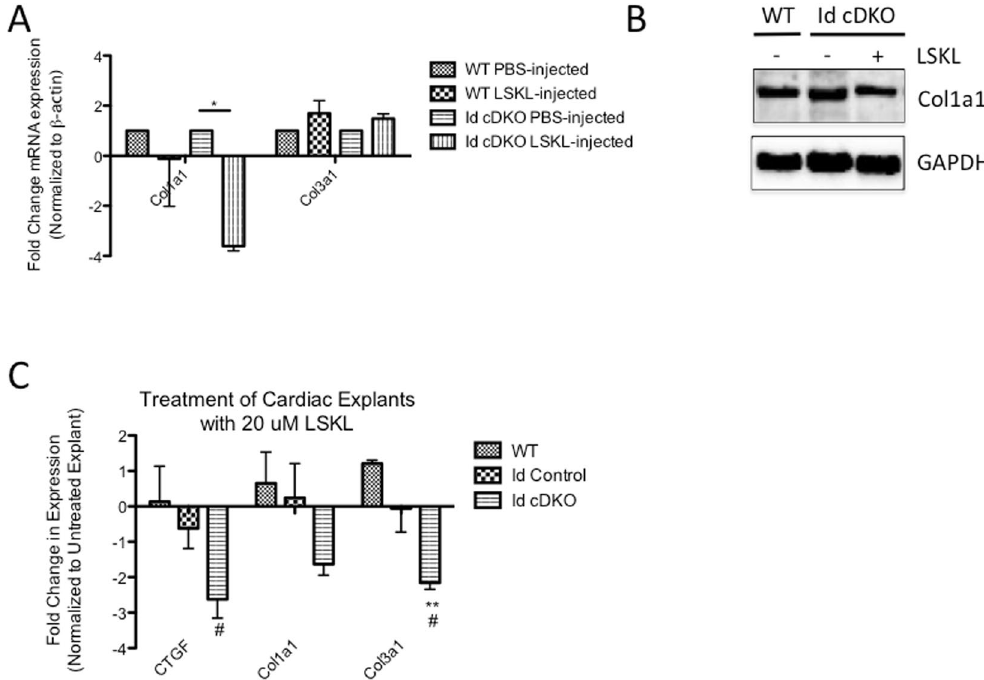
Figure 6. Injection of LSKL in Id cDKO mice antagonizes TSP1activity and leads to downregulation of collagen. ( A ) RT PCR analysis of hearts from WT and Id cDKO injected/not injected with LSKL. Fold change in mRNA expression for Col1a1, Col3a1 in Id cDKO hearts at 2 months of age with PBS vs. LSKL. WT (n = 3 for each treatment group), Id cDKO (n = 3 for each treatment group). * p < 0.05 ( B ) Representative western blot for Col1a1 in hearts from PBS and LSKL injected mice at 2 months age. Quantitation of band intensity provided in graph below, expressed as fold change relative to untreated levels. ( C ) RT PCR analysis of cardiac explants treated with LSKL. Data expressed as fold change in mRNA expression in cardiac explants relative to untreated controls from WT, Id control and Id cDKO mice following treatment with 20 μ M LSKL. WT (n = 3 for each treatment gorup), Id control (n = 4 for each treatment group), Id cDKO (n = 3 for each treatment group) * p < 0.05 (Id cDKO vs. WT), ** p < 0.01 (Id cDKO vs. WT), # p < 0.05 (Id cDKO vs. id control), ## p < 0.01 (Id cDKO vs. Id